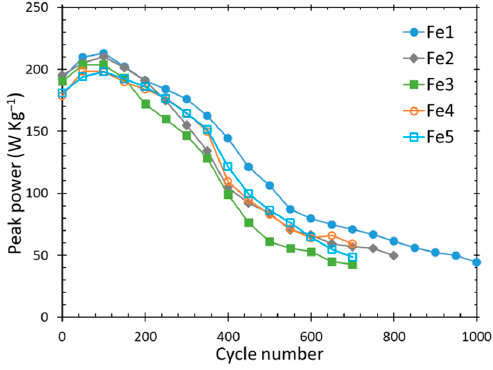
Figure 5. Peak power for cells Fe1 to Fe5 measured at 50% DOD and RT.